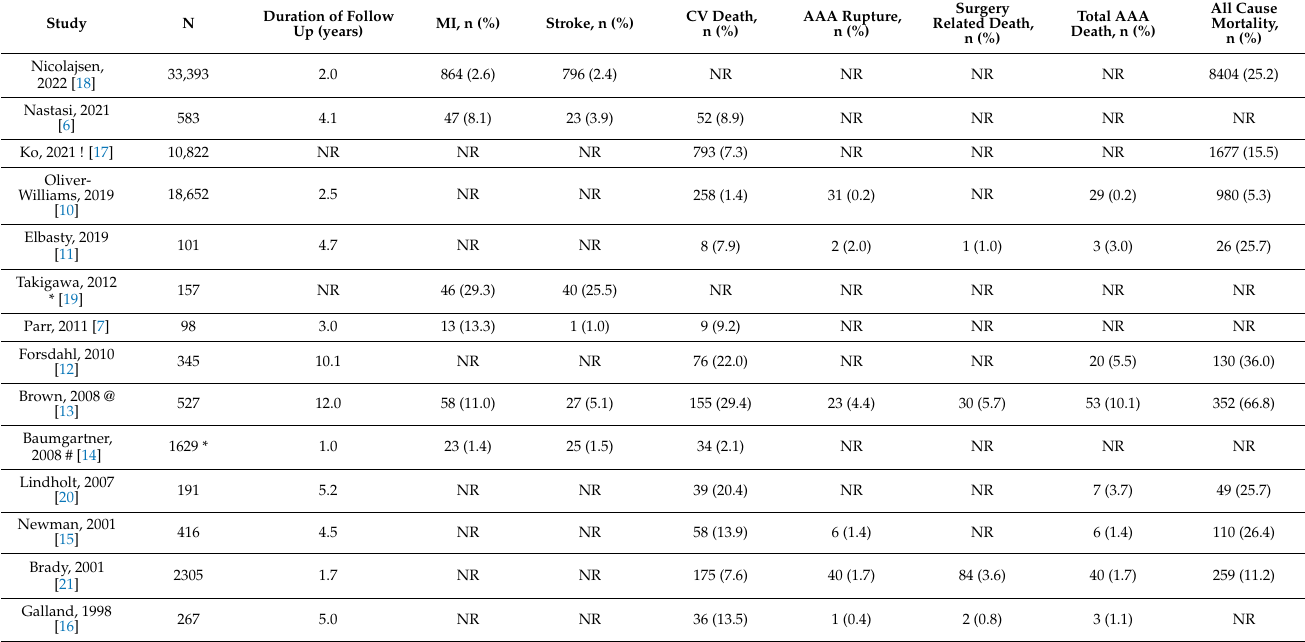
Table 3. Number of cardiovascular events and deaths of participants with unrepaired abdominal aortic aneurysm.